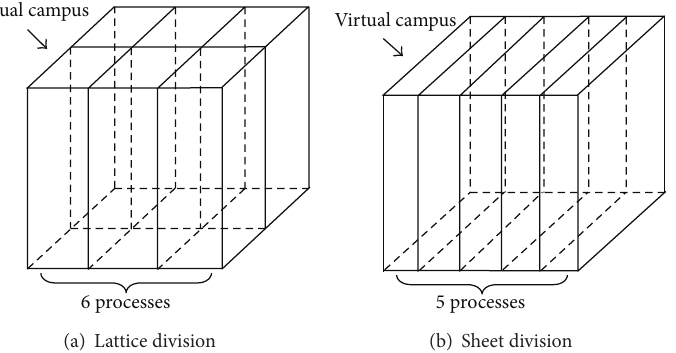
Figure 5: KMC division of virtual